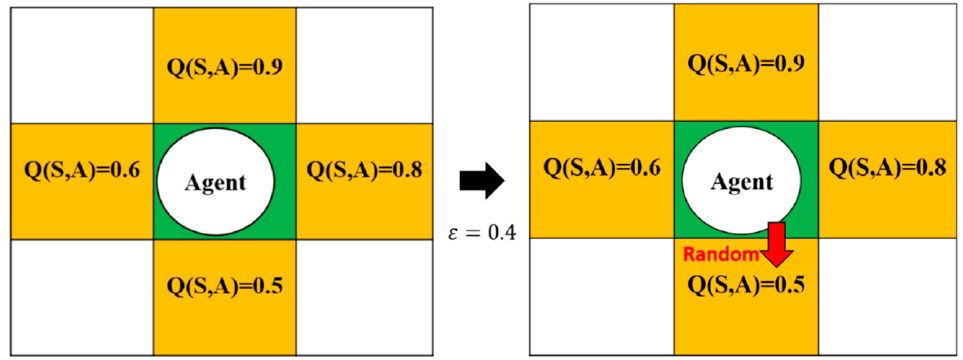
Figure 8. Operation of the ε - greedy policy.